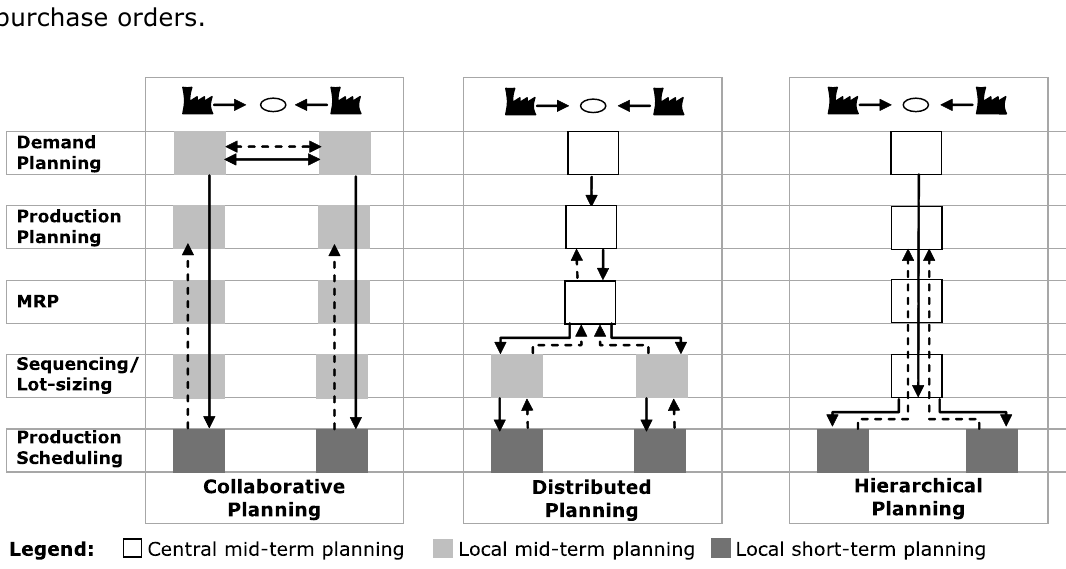
Figure 3. “Local and central planning under a general-purpose plant